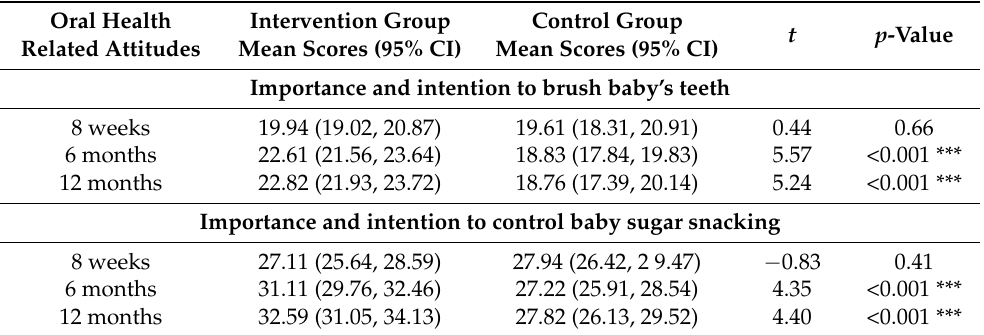
Table 3. Comparison of maternal oral health related attitudes at baseline, 6 months, and 12 months between intervention and control group mothers.